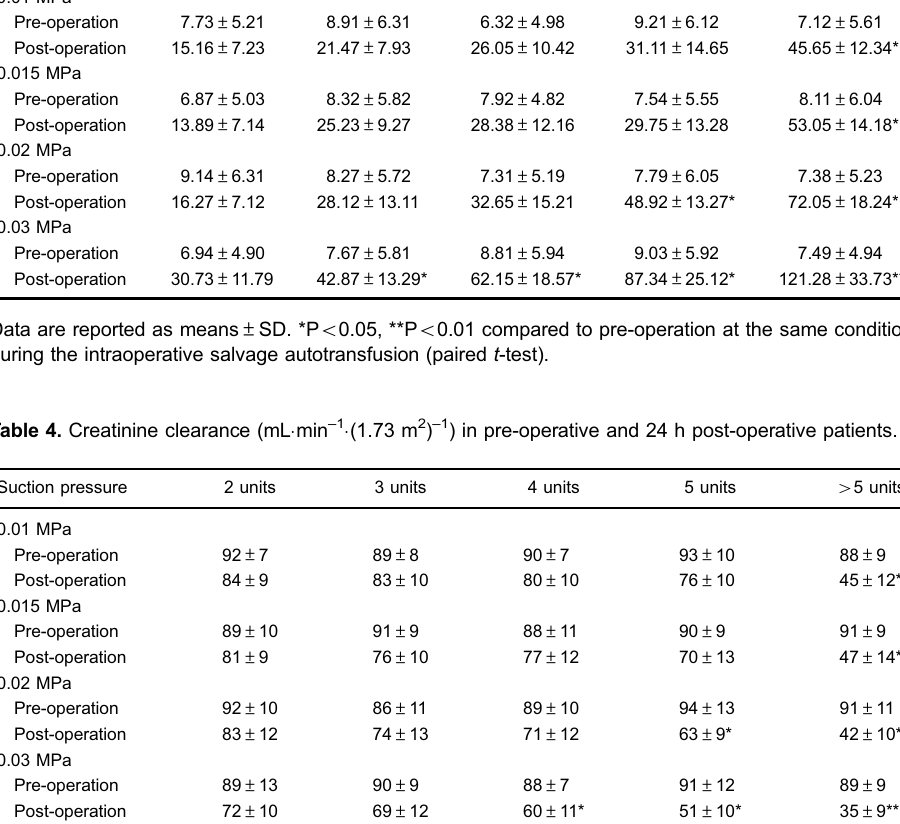
Table 3. Plasma free hemoglobin (mg/dL) content in pre- and post-operative patients at 24 h.